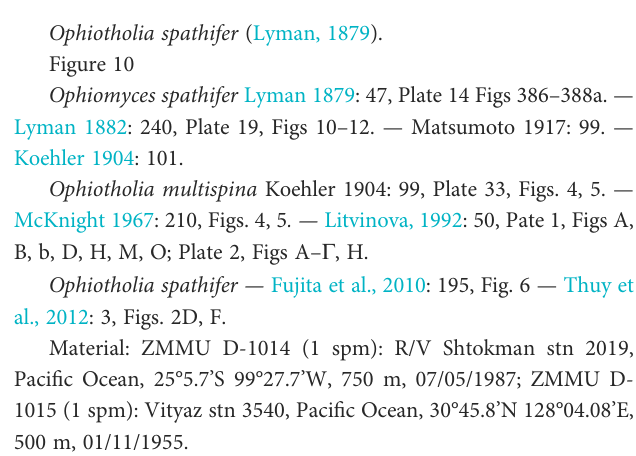
Ophiotholia spathifer (Lyman, 1879). Figure 10